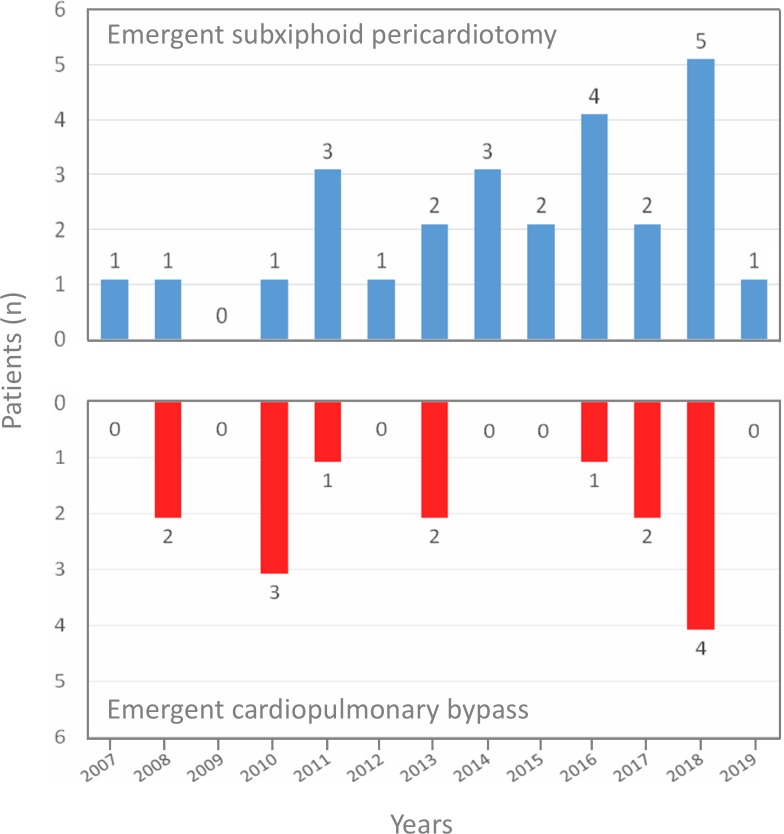
Distribution of rescue procedures during the study period.